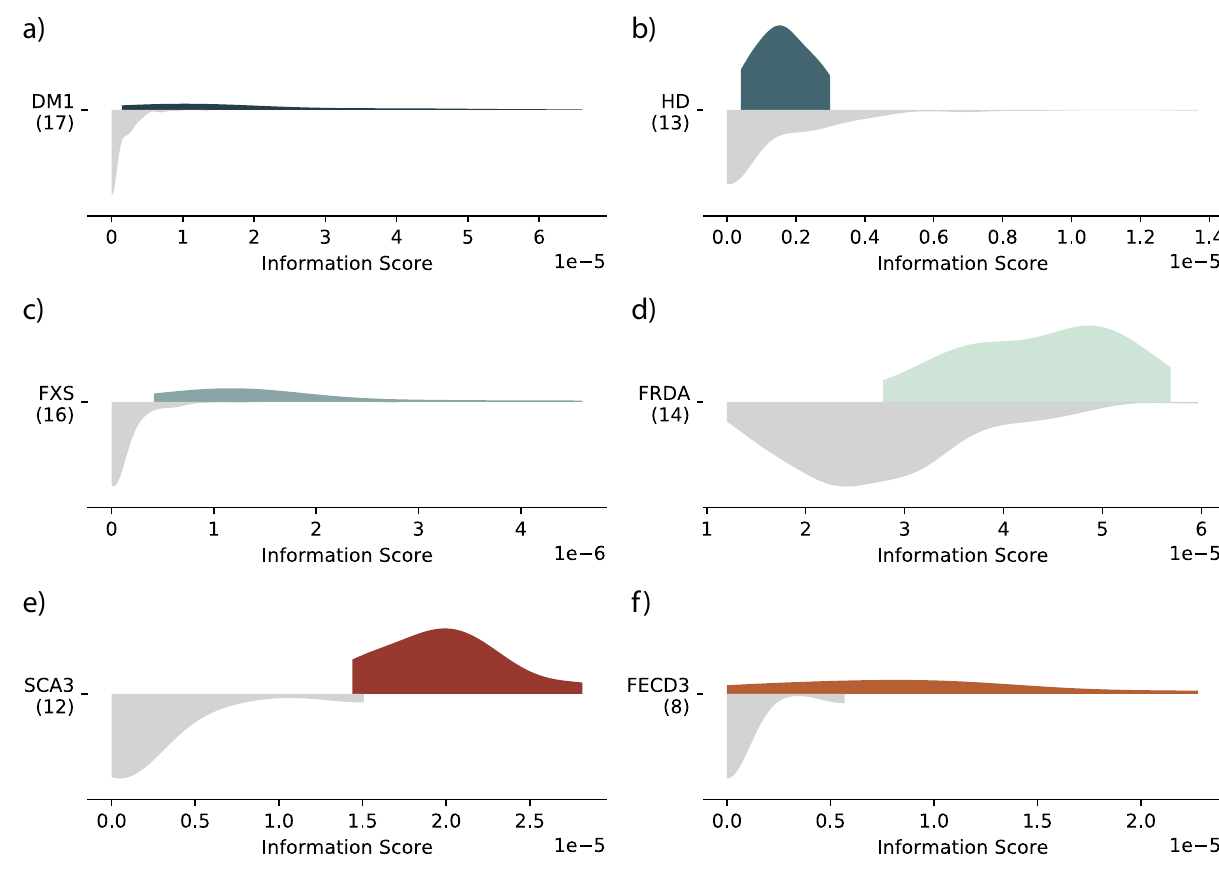
Figure 2. superSTR analysis of WGS and RNA-seq RE data. The distribution of information scores in controls is shown in grey (lower part of each graphic) and affected individuals in color (upper part of each graphic). A right shift in the distribution or the presence of a tail indicates an increased quantity of repeats of that motif in the sequencing data. ( a – d ) show comparison of disease groups within the Illumina RE cohort to the Illumina Diversity cohort. ( e , f ) show RNA-seq analysis. ( a ) AGC profile of DM1-bearing individuals with long-tailed distribution characteristic of relatively large RE; ( b ) AGC profile of HD-bearing individuals with a much shorter RE; ( c ) CCG profile of FXS individuals; ( d ) AAG profile of FRDA individuals. ( e ) RNA-seq AGC profile of peripheral blood mononuclear cells from 12 individuals with SCA3 RE against 12 matched non-SCA3 controls. ( f ) RNA-seq AGC profile of from eight patients with confirmed FECD3 expansions and six controls without FECD (of any TCF4 (associated with Fuchs’ endothelial corneal dystrophy type 3 (FECD3)), an intronic CAG expansion in the CA10 gene, and an apparent heterozygous expansion at the locus associated with spinocerebellar ataxia type 1